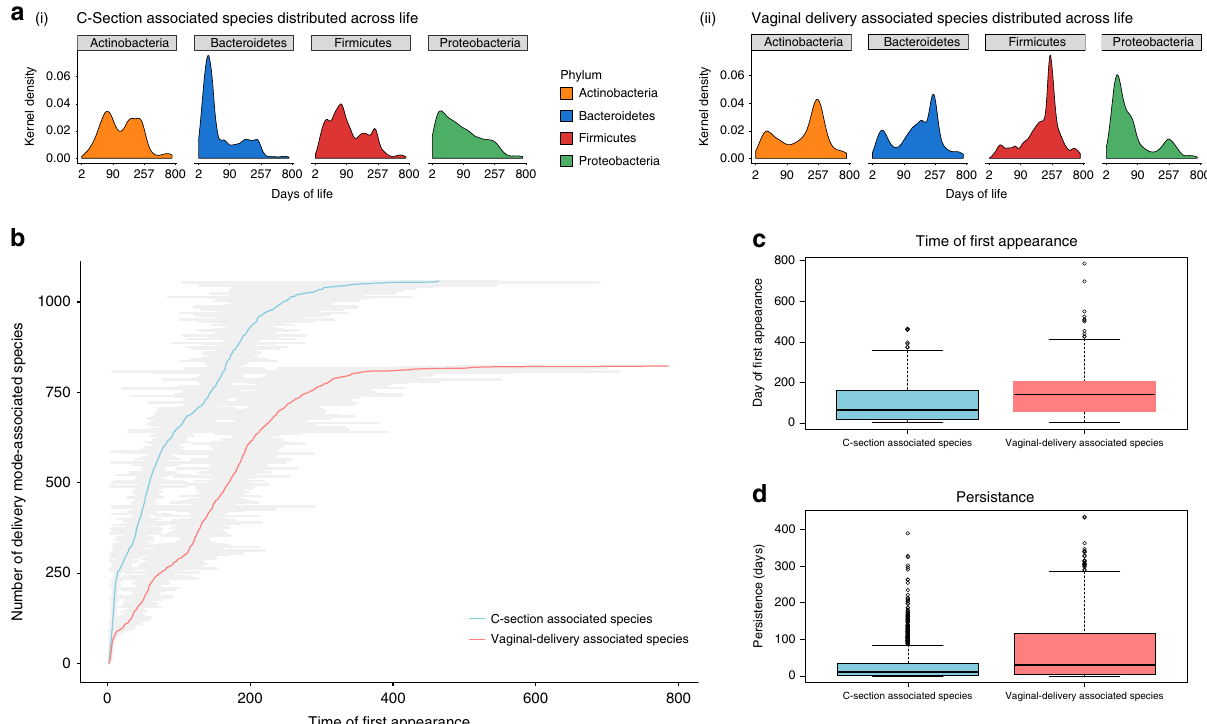
Fig. 4 Mode of delivery drives historical contingency effects on rumen microbiome development. a (i) Major phylum distribution differs between delivery-mode groups and shows long-term repercussions for mode of delivery. Major phylum kernel density (see Material and methods section for further elaboration of kernel density), depicting signi fi cant differences in species (OTUs) count over time, originating from the two delivery-mode groups: C- section (left (i)) and vaginal delivery (right (ii)) ( P < 0.001; see Supplementary Figures and Results). b Early invasion of C-section-associated microbes. Mean± SE for time of fi rst arrival of delivery mode-associated species. Red line represents average day of appearance of vaginal delivery-associated species ( n = 809), blue line of C-section-associated species ( n = 1041), gray bars are SE. X -axis depicts the fi rst day of appearance, Y -axis depicts the number of delivery mode-associated species arriving in each group. Microbes were ordered by time of appearance. c Mean fi rst appearance day for each delivery mode-associated microbe cohort is signi fi cantly lower in the C-section cows ( t -test, P = 2.2 × 10 – 15, two-sided test). d Mean maximum time of colonization, depicted as the delta between time of fi rst appearance in any cow to time of last appearance in any cow, is higher in vaginally delivered cows. Colonization time for C-section-associated species is signi fi cantly lower ( t -test, P = 2.2 × 10 – 15, two-sided test). In the data shown as box plots ( c , d ),boxes represent the interquartile range (IQR) between the fi rst and third quartiles (25th and 75th percentiles, respectively) and the horizontal line inside the box de fi nes the median. Whiskers represent the lowest and highest values within 1.5 times the IQR from the fi rst and third quartiles, respectively. Source data is provided as a Source Data fi points (1, .., t − 1). We termed these predictable microbes as autoregressive microbes (Fig. 5a). By applying the MTV-LMM method, we detected 1389 autoregressive microbes (Fig. 5b; median Pearson correlation coef fi cient r = 0.26, P < 0.0001, t -test, two-sided test).